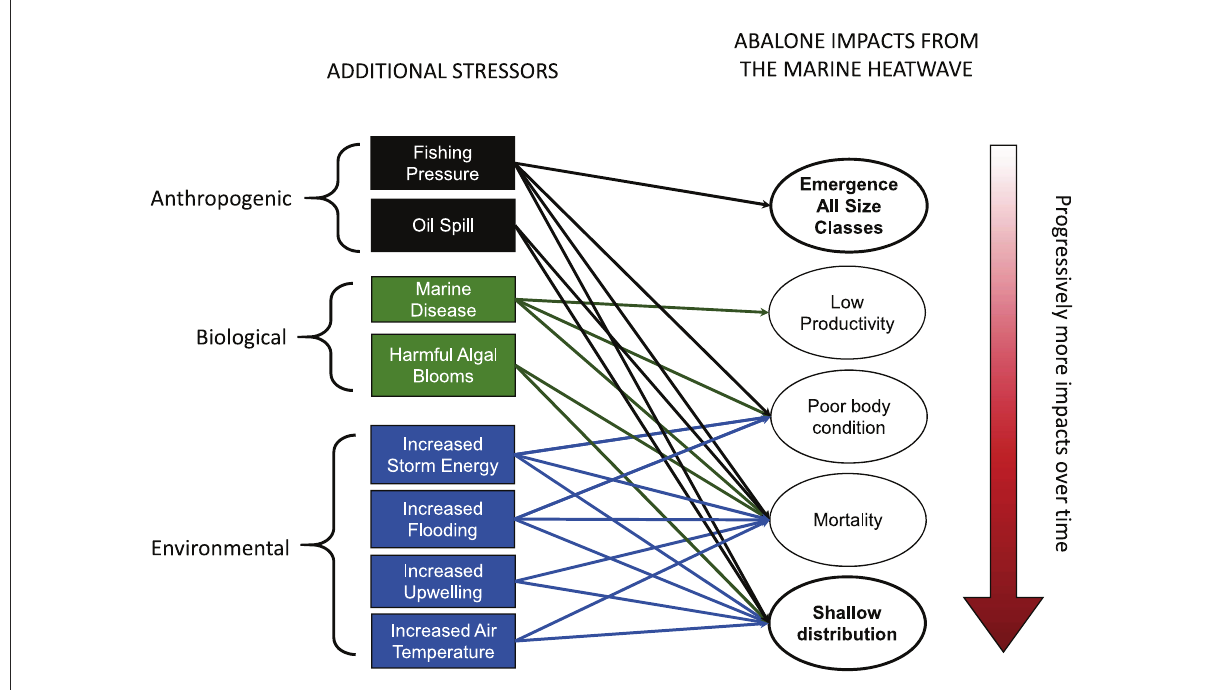
FIGURE9 Conceptual Model (details of “resource impact” and “additional stressors” explored)—Abalone Example Interaction of additional stressors with consequences of MHW bold outline = unanticipated